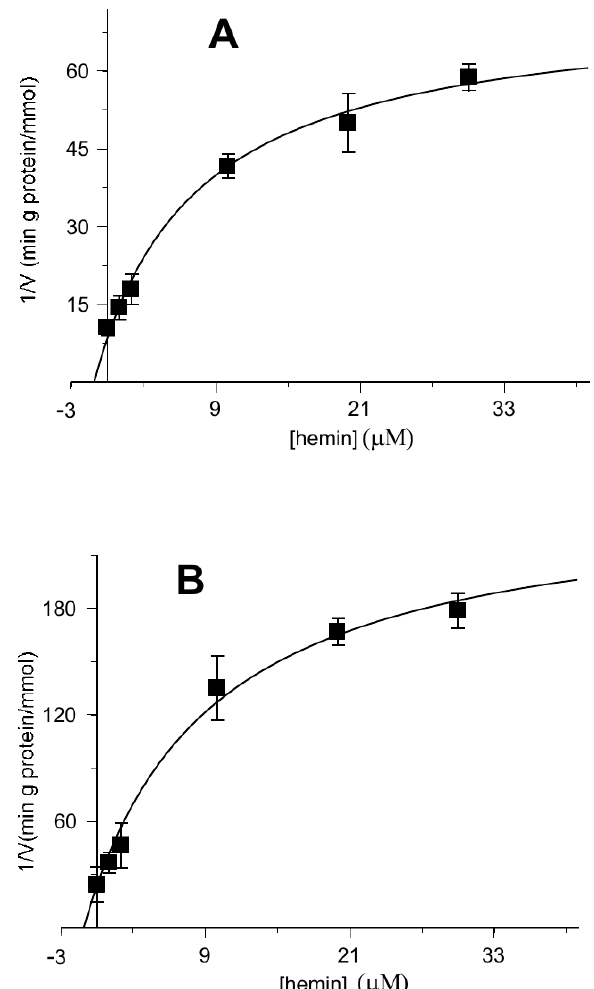
Figure 5. Kinetic analysis of the inhibition data of Figure 2 of the reconstituted oxoglutarate/oxoglutarate and malate/oxoglutarate exchanges by hemin using the Dixon plot. Hemin was added together with 0.05 mM of [ 14 C] 2-oxoglutarate ( A ) or 0.05 mM [ 14 C] malate ( B ) to proteoliposomes containing 6 mM of 2-oxoglutarate in the absence or in the presence of increasing hemin concentrations (1–30 µM).